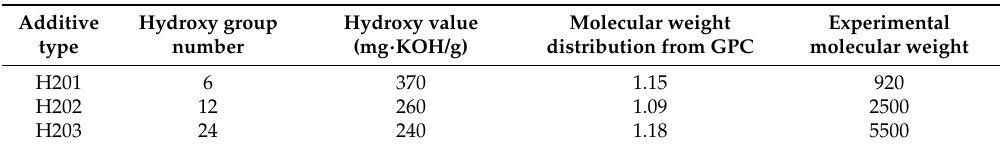
Table 1. Properties of experimental additive